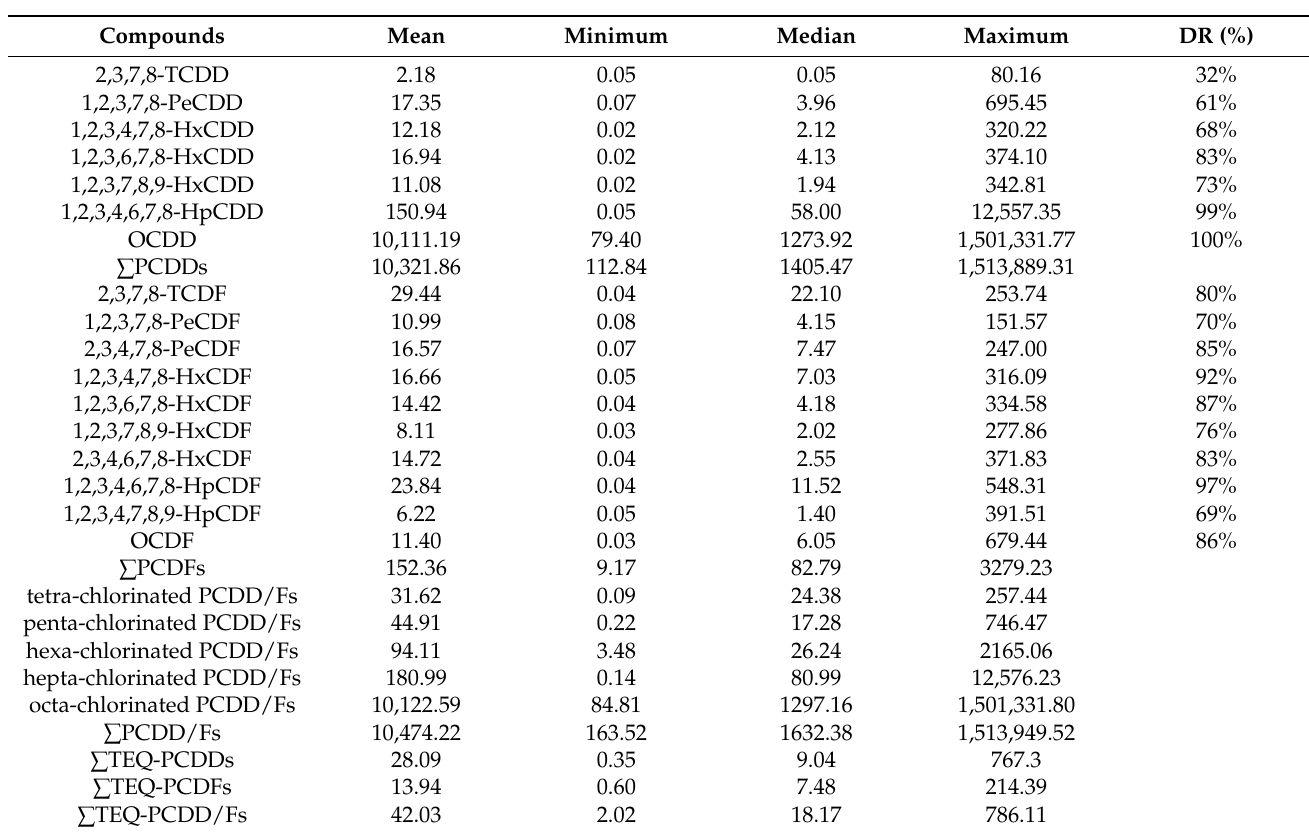
Table 2. Concentrations of PCDD/Fs in maternal serum, expressed as pg/g lipid ( n =